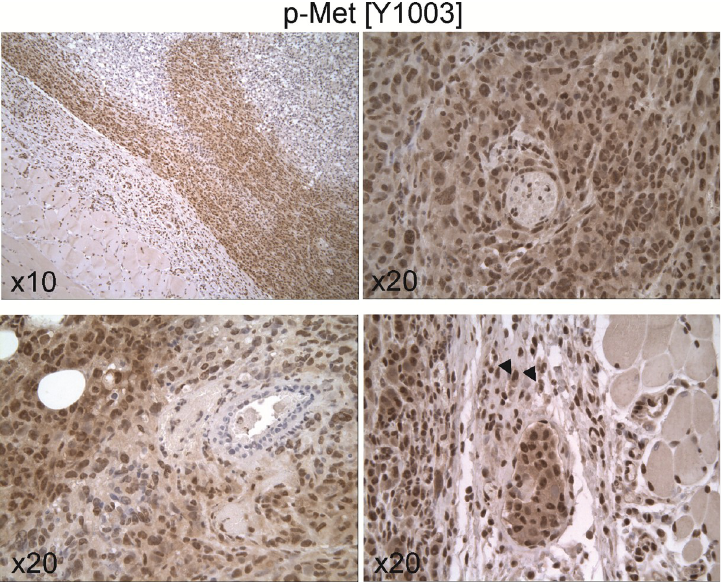
Fig 6. Expression and cellular distribution of p-Met[Y1003] in untreated 231/LM2-4 tumor xenografts. Immunohistochemistry for p-Met[Y1003] shows intense widespread staining in the vital areas of the tumor, with both nuclear and cytoplasmic localization. In certain tumor areas, a large amount of reactive stroma was present, which showed strong cytoplasmic and nuclear staining (down-right arrows).